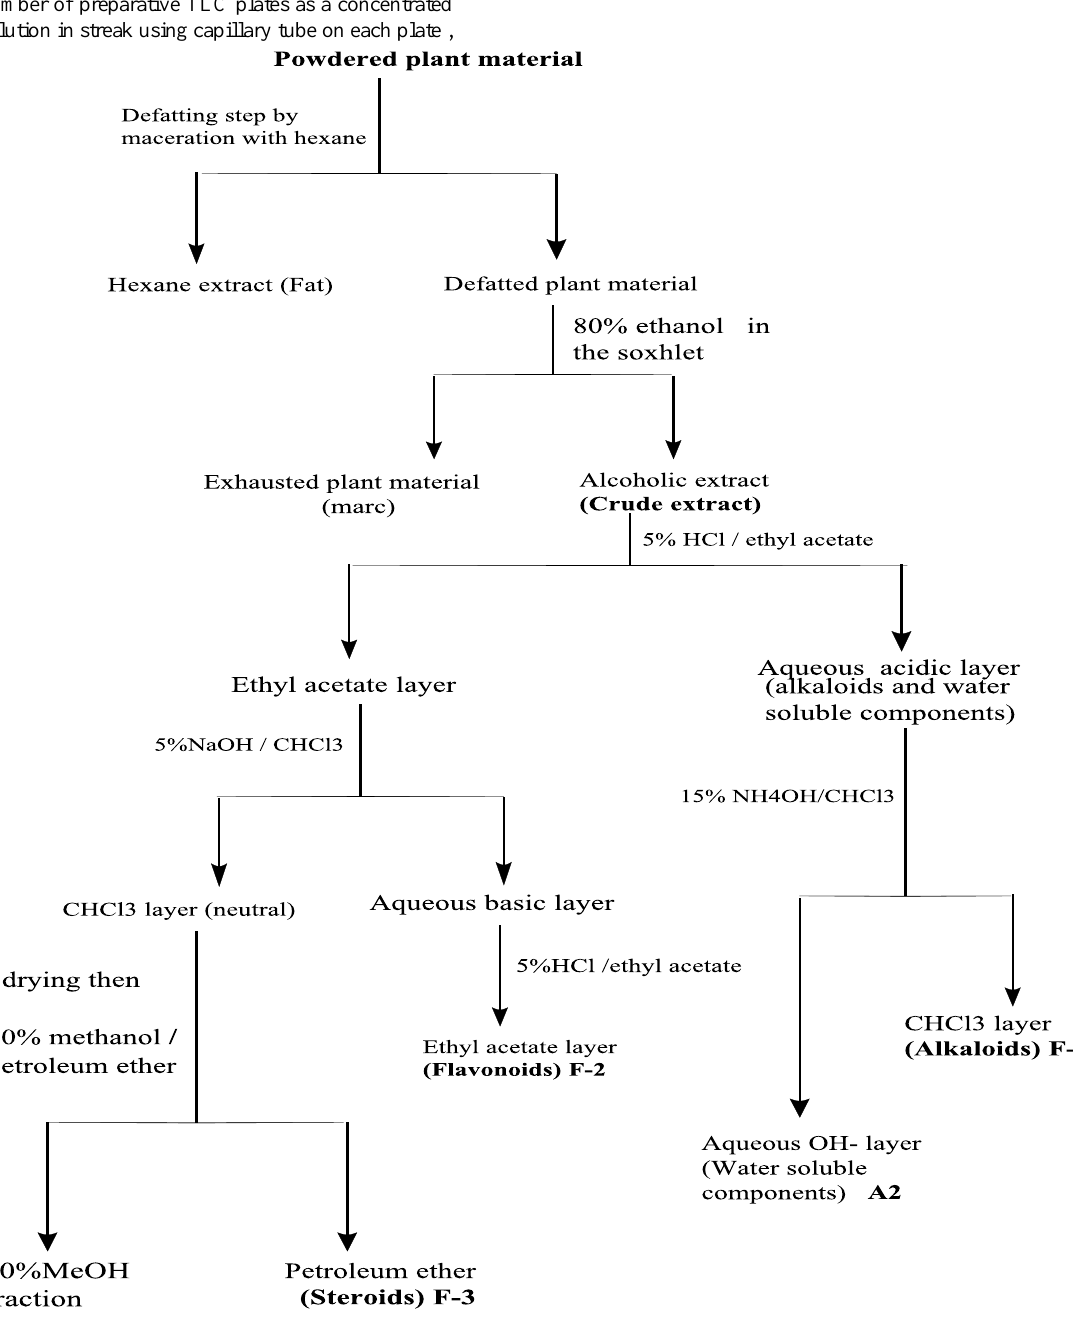
Figure 3. General scheme for separation of different plant constituents